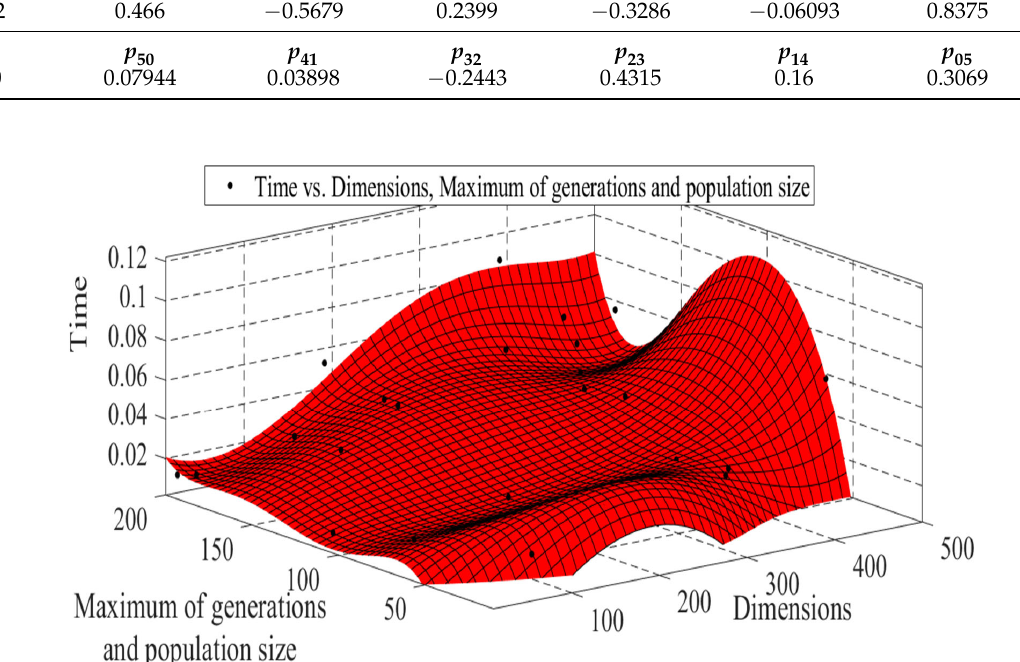
Figure 20. The surface of fitting the calculations time.